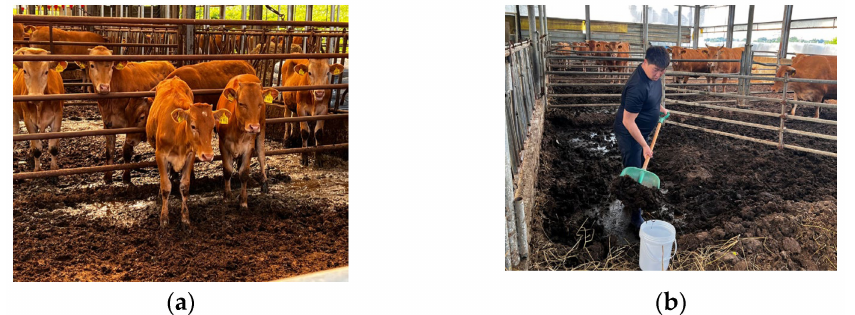
Figure 1. Sampling site ( a ) and collecting procedure ( b ) for cattle manure in Icheon-si, South Korea. Table 1. The characteristic properties of cattle manure.